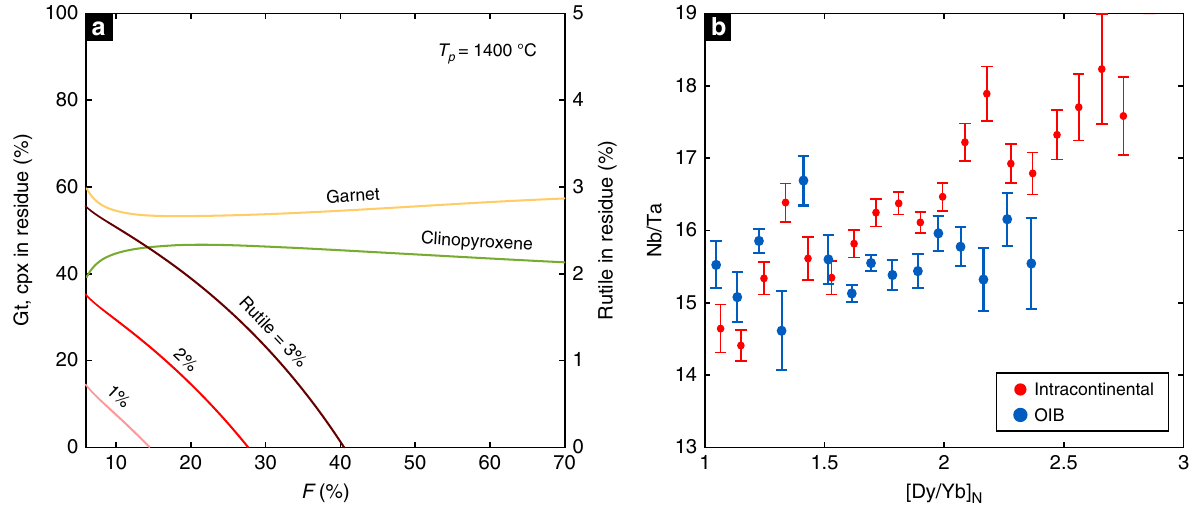
Fig. 4 Remelting rutile-bearing arclogites in the mantle. a Percentages of garnet, clinopyroxene, and rutile in the residue during decompression melting of low Mg# arclogites (5 − 2 GPa, T p = 1400 °C). The results are from pMELTS simulations 41 . We considered 1 − 3% rutile in the solid before melting. The upper bound on the average amount of rutile in the low Mg# arclogites can be calculated from the difference in TiO 2 content between the average rutile- bearing and rutile-free arclogites, which is 1.37 wt.%. b Nb/Ta vs. chondrite-normalized (Sun and McDonough 64 ) Dy/Yb in intracontinental basalts ( n = 4903) and ocean island basalts ( n = 1915). Errors are two standard errors (2 se)